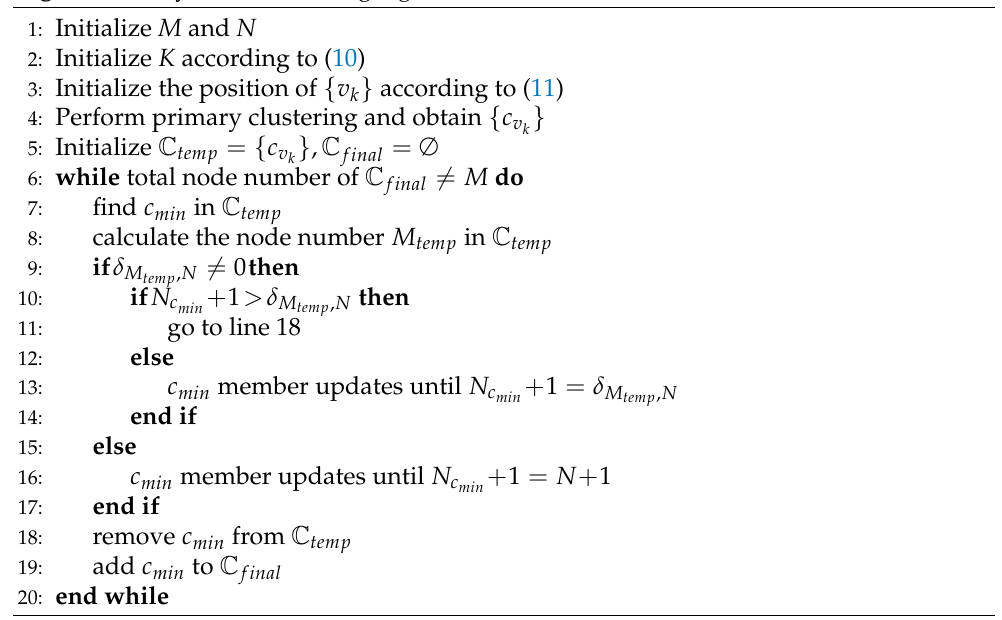
Algorithm 1 for the pseudo-code of dynamic clustering. Algorithm 1 Dynamic clustering